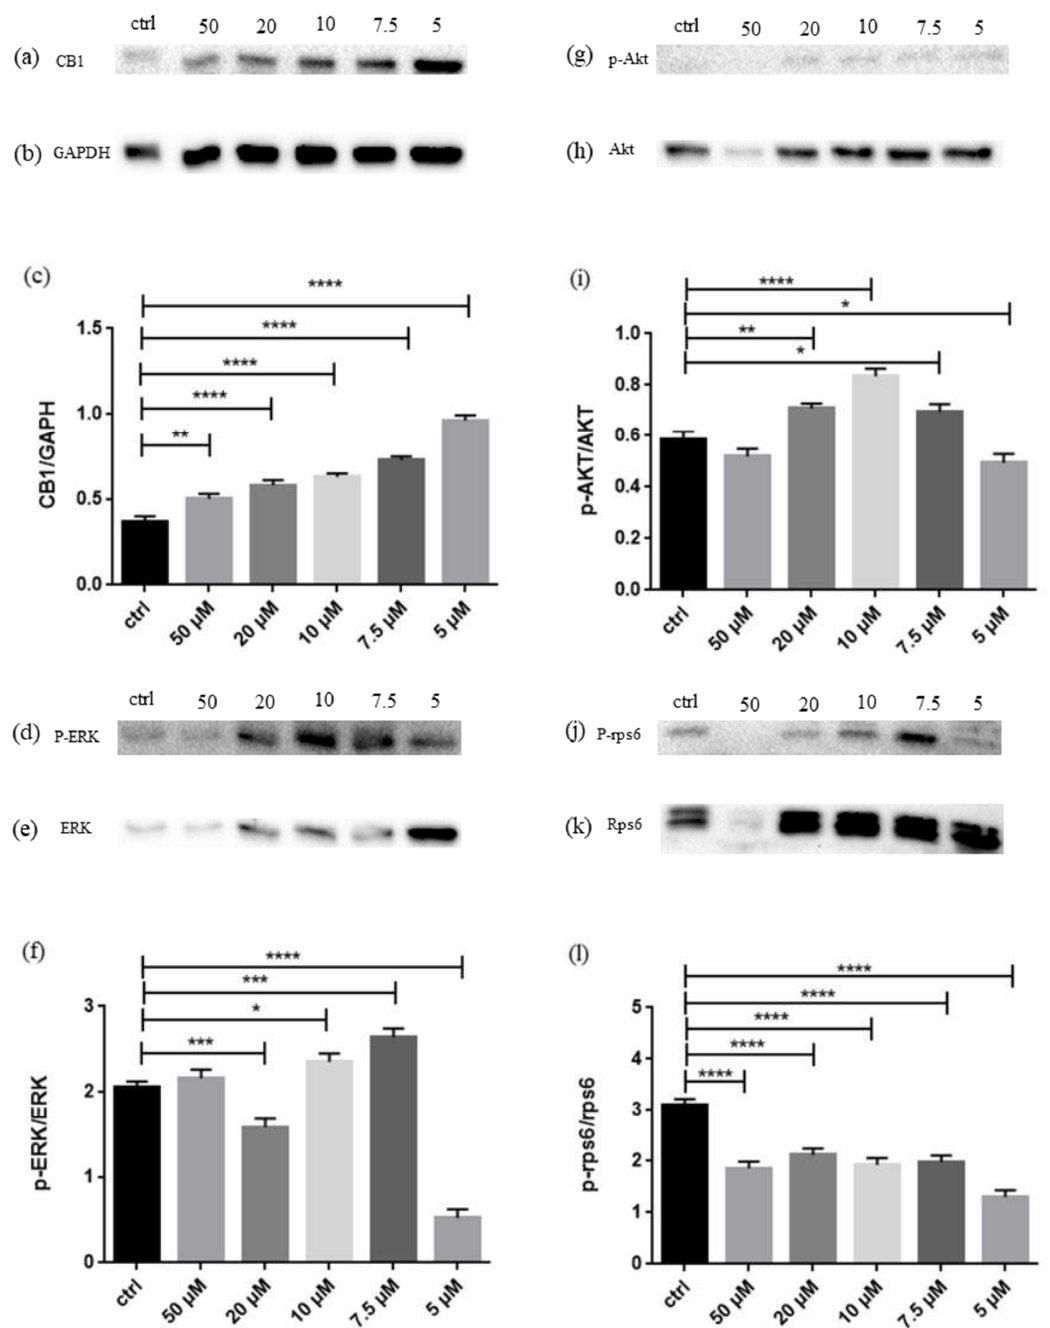
Figure 3. ( a ) Evidence of significant increase of CB1 in NSC-34 after treatment with CBNR; ( b ) GAPDH used for normalization; ( c ) densitometric analysis of CB1, ** p < 0.005. **** p < 0.0001; ( d ) Evidence of different phosphorylation degree of ERK at different doses; ( e ) not-phosphorylated ERK used for normalization; ( f ) densitometric analysis of p-ERK, * p < 0.05. *** p = 0.0001. **** p < 0.0001; ( g ) Evidence of different phosphorylation degree of Akt at different doses; ( h ) non-phosphorylated Akt used for normalization; ( i ) densitometric analysis of p-Akt, * p < 0.05. ** p < 0.005. **** p < 0.0001; ( j ) Evidence of different phosphorylation degree of rps6 at different doses; ( k ) non-phosphorylated rps6 used for normalization; ( l ) densitometric analysis of p-rps6, **** p < 0.0001.